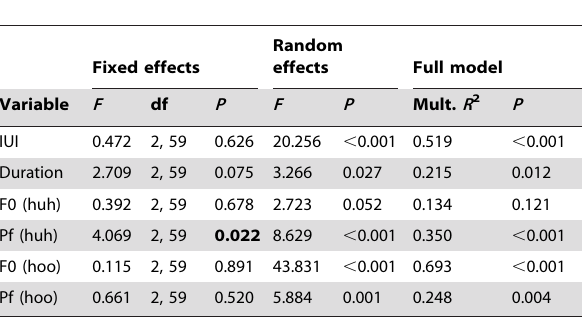
Table 4. Variation in relation to call